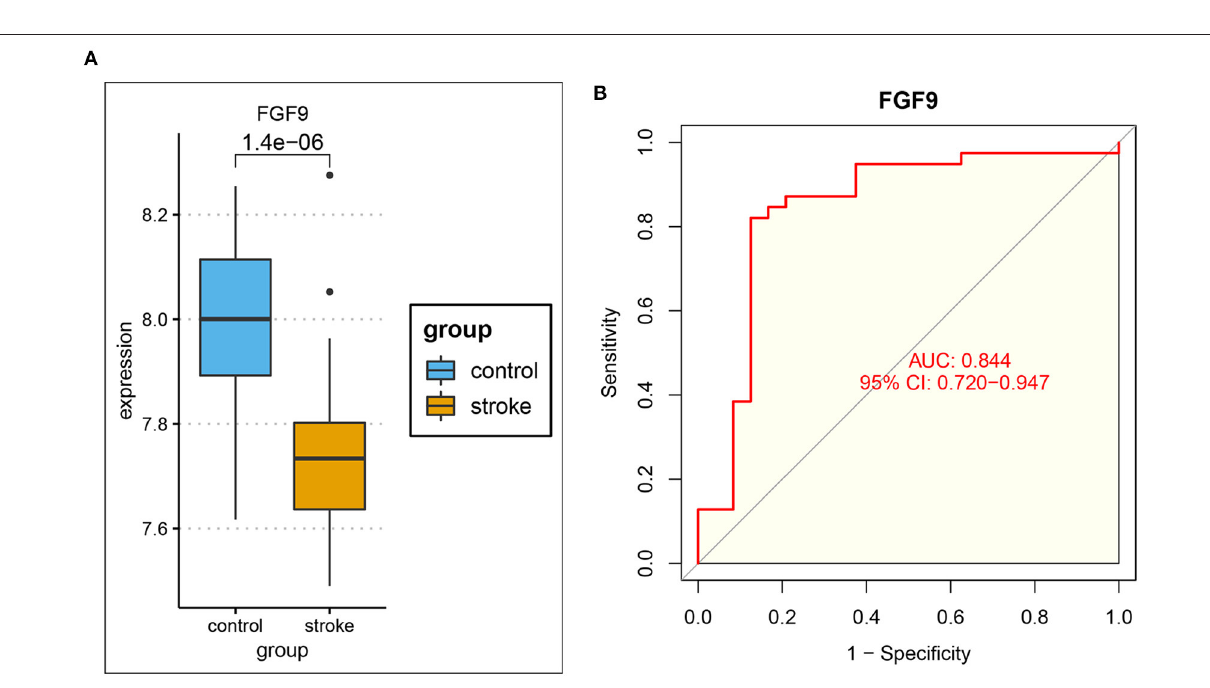
FIGURE 7 | Validation of FGF9 in the independent dataset GSE16561. (A) The expression of FGF9 was significantly down-regulated in IS patients compared to controls. (B) ROC curve analysis indicated that the expression of FGF9 was significantly associated with the diagnosis of IS (AUC =